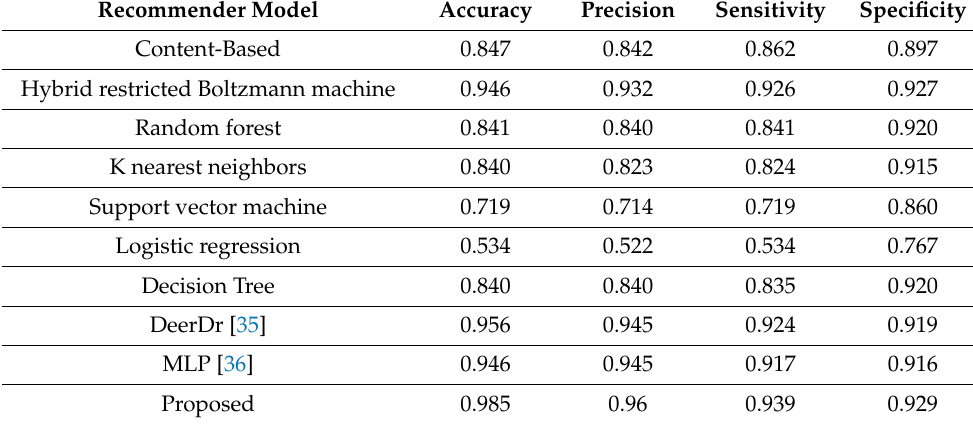
Table 4. Comparison of the performance metrics of machine learning-based recommender